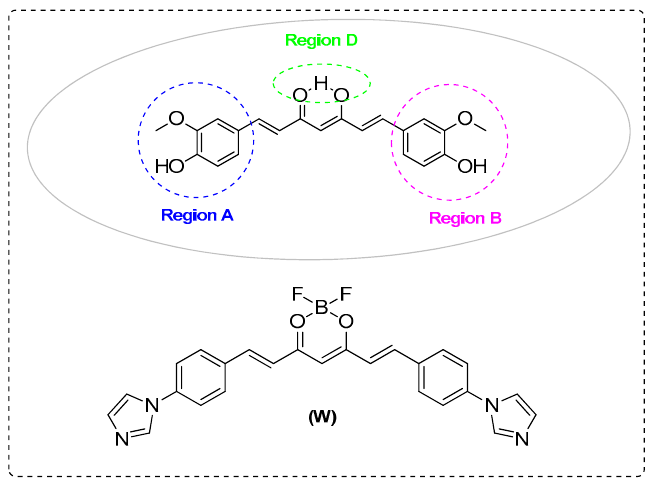
Figure 4. of amyloid- β aggregation. Figure 4. Inhibitors of amyloid- β aggregation.